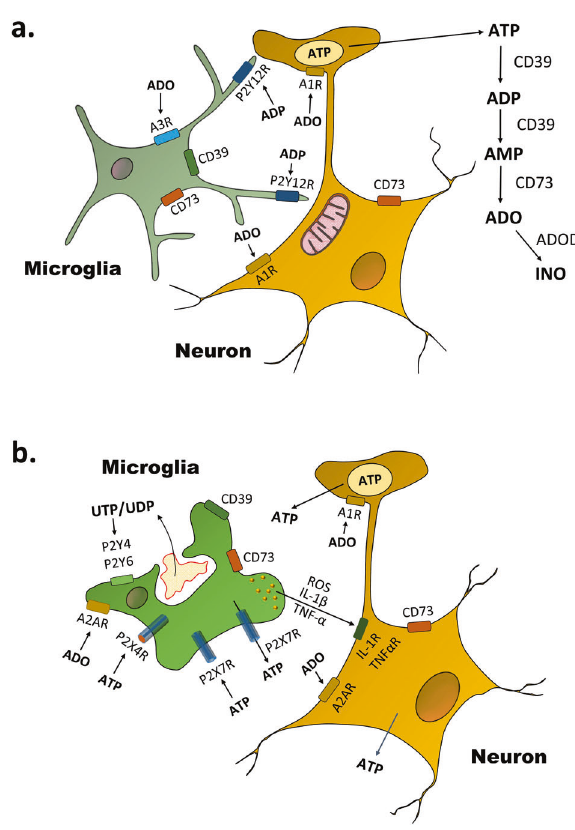
Fig. 1 Microglia – neuron cross-talk at different microglial activation states. a Surveilling/rami fi ed microglia send their processes to the ATP-releasing terminals of neurons as well as to their somata where the plasma membrane covers ATP-producing mitochondria. Neu- ronally released ATP is gradually degraded by CD39 to ADP and AMP, and then by CD73 to adenosine (ADO). Adenosine is inactivated by adenosine deaminase (ADOD) to inosine (INO). P2Y12Rs respond to transmitter ATP or somatically released ATP by increased coverage by microglial processes of these neuronal sites. A3Rs and P2Y12Rs act in concert to promote microglial process motility. Adenosine feeds back via presynaptic or somatic A1Rs to inhibit neuronal activity. b Activated/ameboid microglia phagocytose bacteria or cellular debris. ATP may be again released as a neurotransmitter but may also leave the neuronal cytoplasm via holes in the damaged cellular membrane. In addition, ATP is outpouring from neighboring astrocytes mainly through connexin channels and pannexin-1 hemichannels in a nonexocytotic manner. Instead of P2Y12Rs, now P2X7Rs are the main microglial sites at which ATP acts. P2X7Rs are pathways for the release of ATP, and more importantly, they induce the production/release of proin- fl ammatory cytokines (IL-1 β , TNF- α ) and reactive oxygen species (ROS). These cell products cause neuroin fl ammation and subse- quent neuronal damage through the activation of their speci fi c receptors (IL-1R, TNF α R). P2X7Rs act in synchrony with P2X4Rs. A2ARs promote the transition of rami fi ed microglia to ameboid microglia. UDP-sensitive P2Y6Rs trigger microglial phagocytosis, while UTP (ATP)-sensitive P2Y4Rs trigger microglial pinocytosis. UTP/ UDP derives from the nucleus of injured cellular material. Whereas A1Rs at neurons are inhibitory, A2ARs are excitatory and they promote